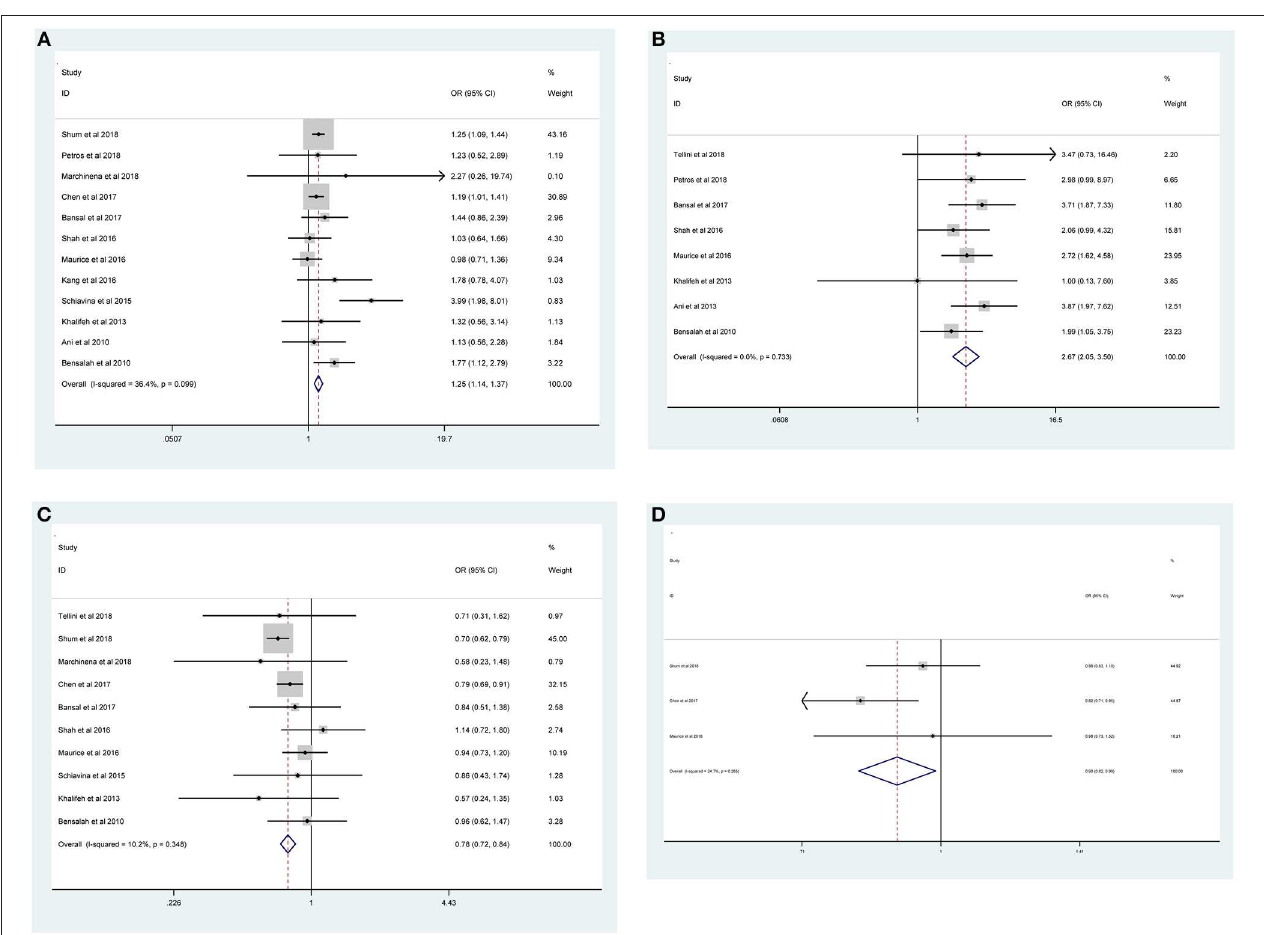
FIGURE 2 | Forest plots of studies evaluating the prognostic factors for (A) higher Furhman grade, (B) higher pathological stage, (C) non-ccRCC histology, and (D) non-white race with PSMs.